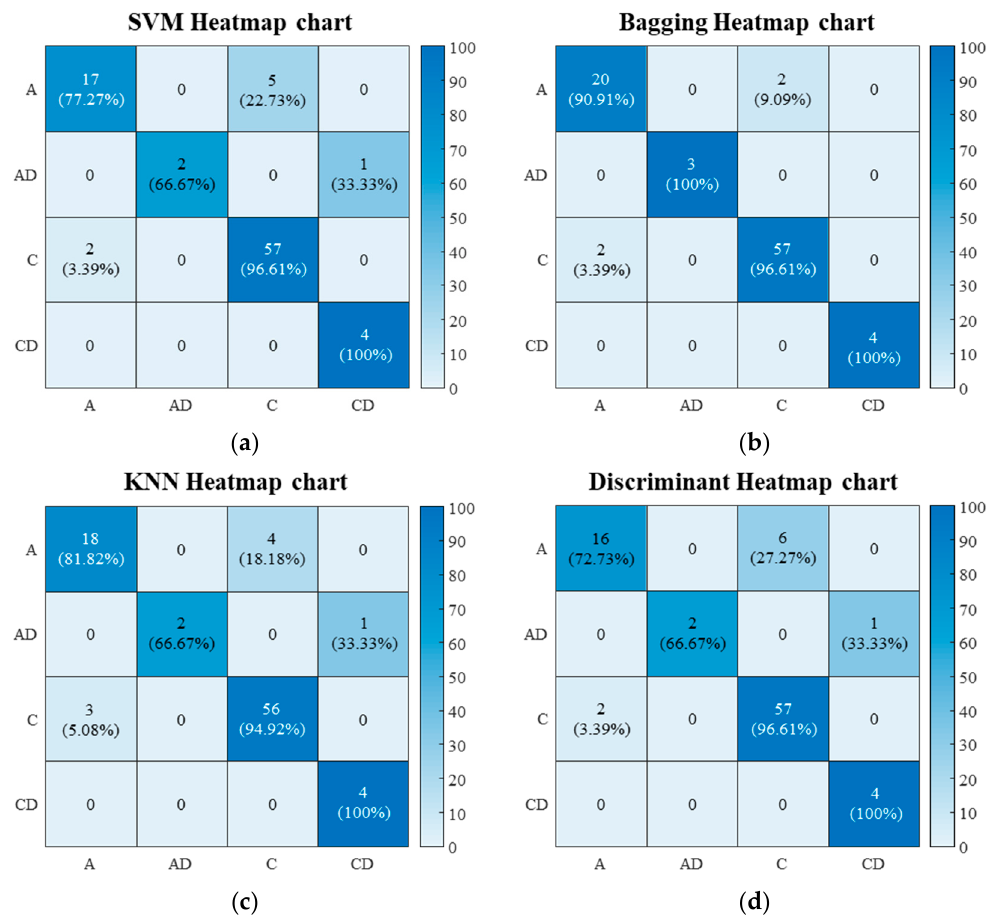
Figure 13. Heatmap chart of prediction results using developed machine learning classifiers: ( a ) the heat map result of the SVM classifier; ( b ) the heat map result of the bagging classifier; ( c ) the heat map result of the kNN classifier; ( d ) the heat map result of the DA classifier.